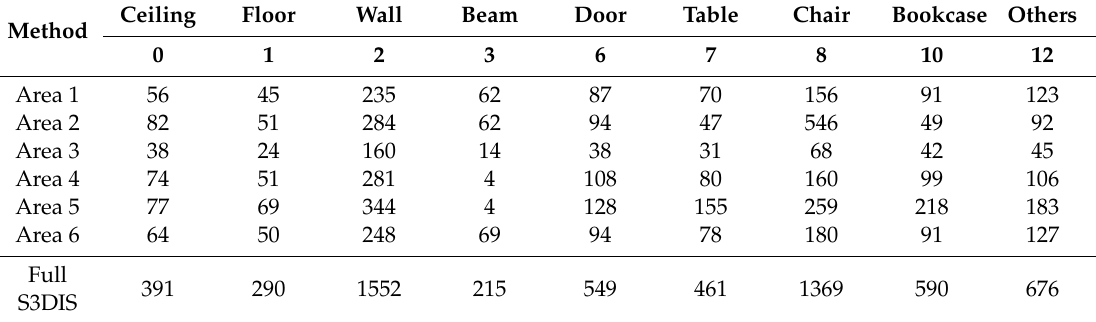
Table 5. S3DIS per-area statistics regarding the studied